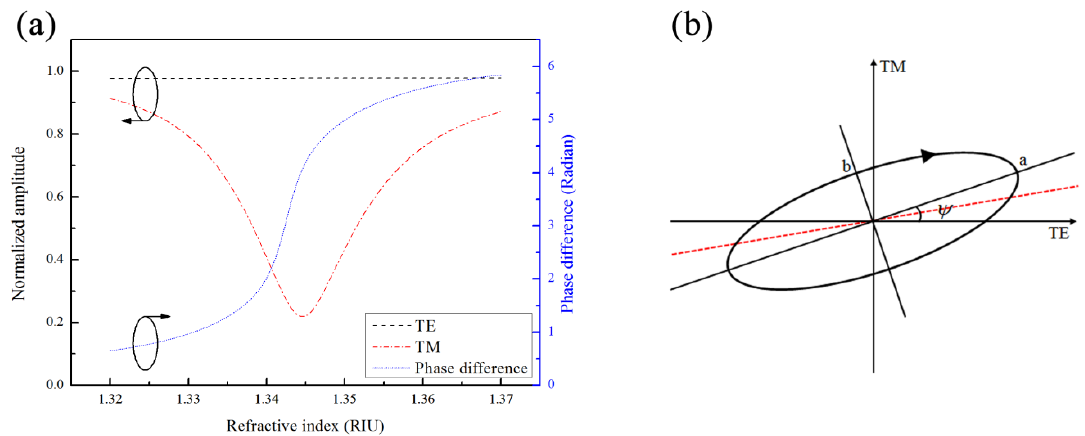
Figure 2. ( a ) Normalized amplitudes and mutual phase difference of light waves after GMR; ( b ) sketch of a polarization